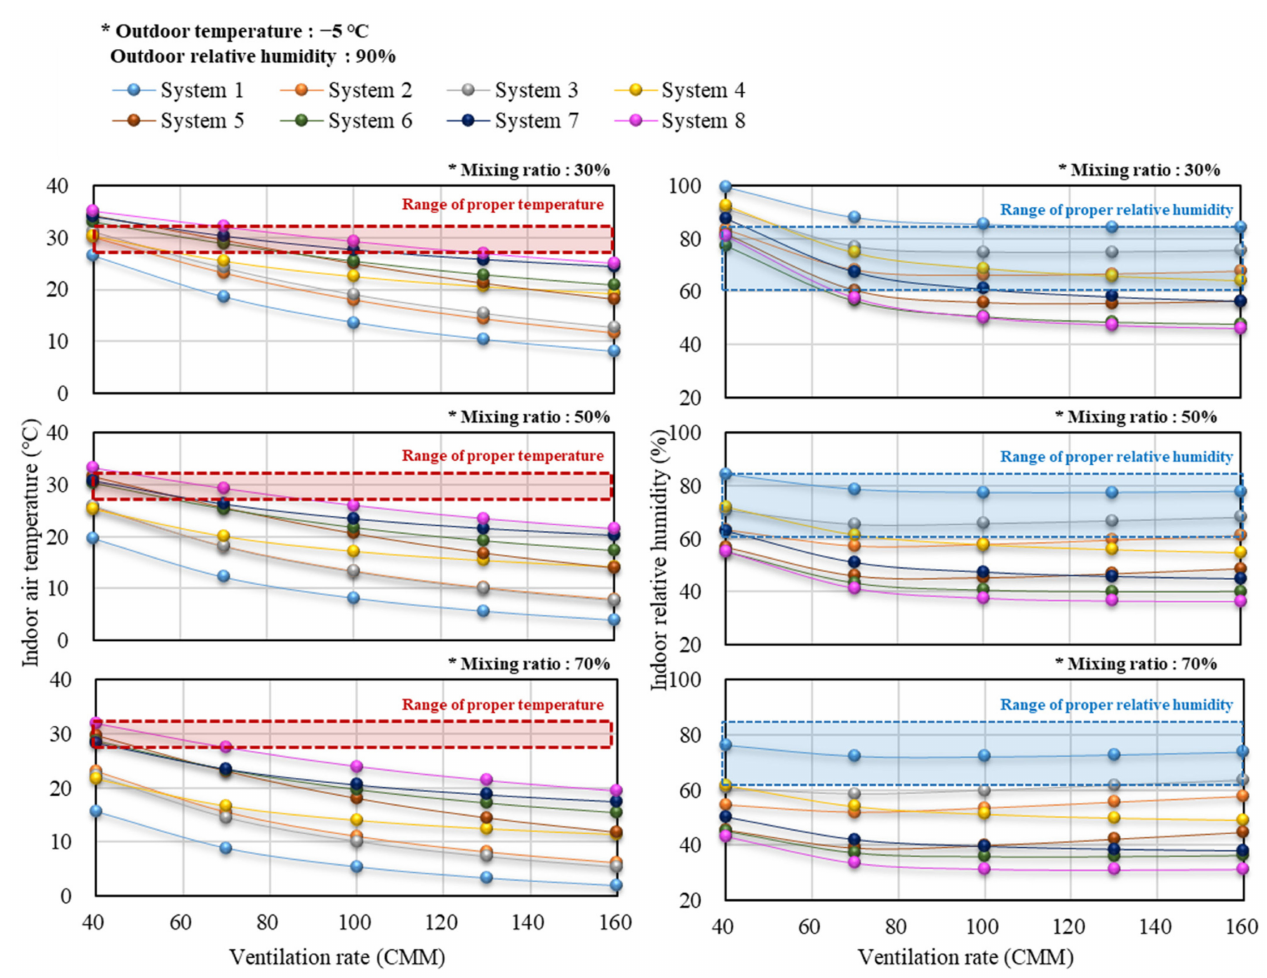
Figure 10. The air temperature and relative humidity inside the experimental piglet room by ARVS according to the ventilation rate and the external air mixing ratio (external air temperature − 5 ◦ C, external air relative humidity